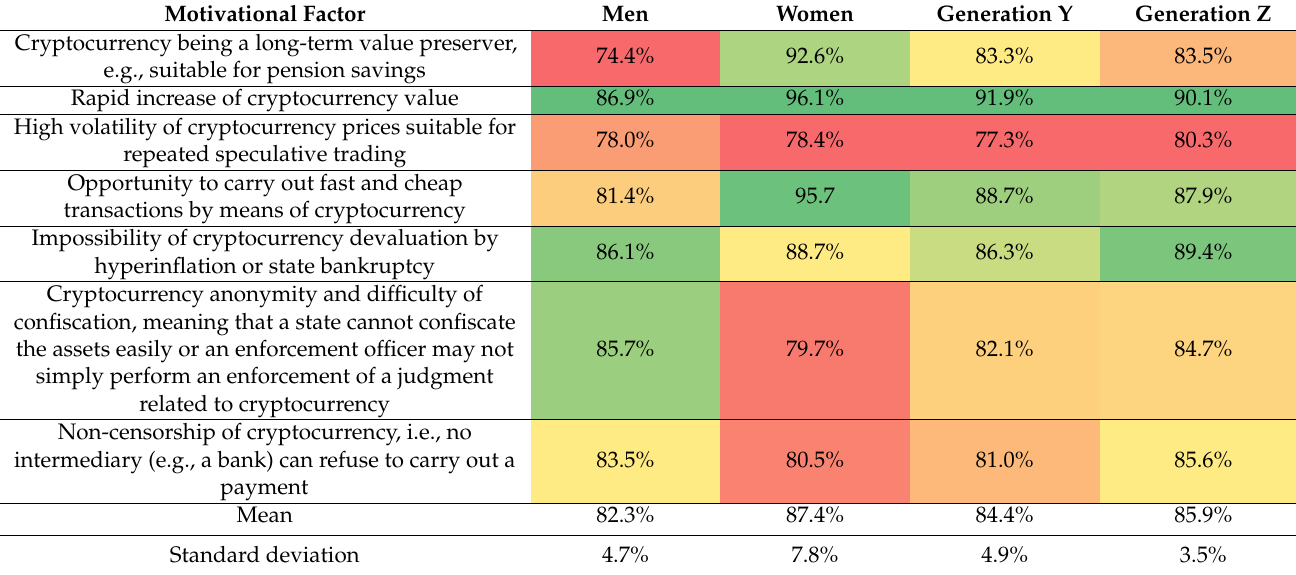
Table 7. Percentage of respondents encouraged to invest in cryptocurrency by the given factor. The table includes respondents that have and do not have a tendency to take risks. The respondents are divided into the following categories: Men, Women, Generation Y, and Generation Z, and the green-yellow-red scale is selected for the entire